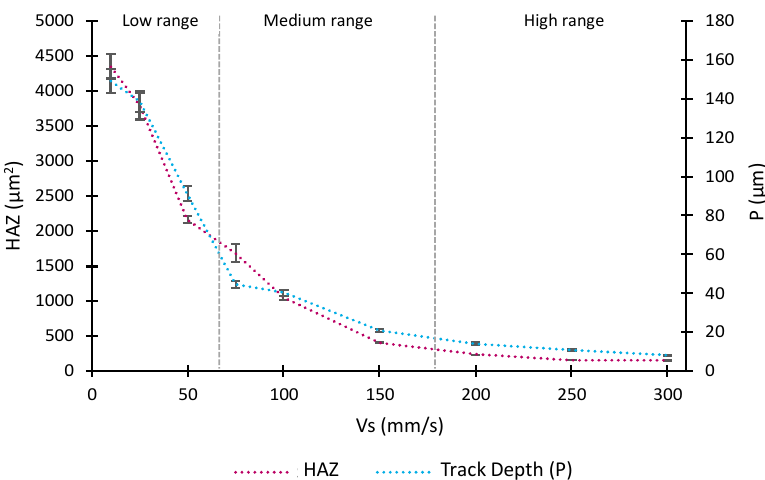
Figure 4. Heat-a ff ected zone (HAZ) and depth of laser tracks as a function of V s Figure 4. Heat-affected zone (HAZ) and depth of laser tracks as a function of V s.